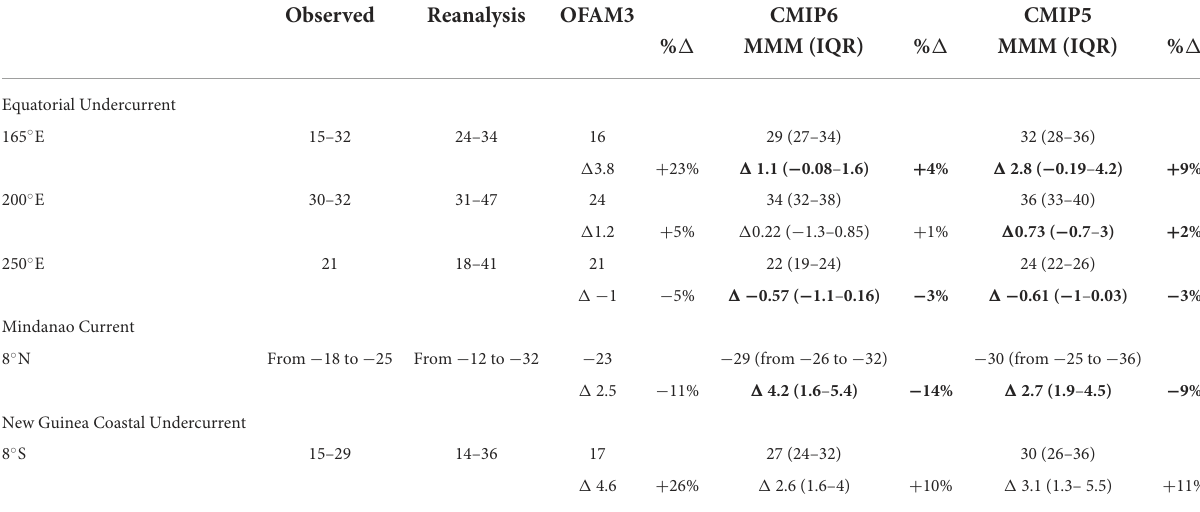
TABLE 1 Summary of historical and projected transport